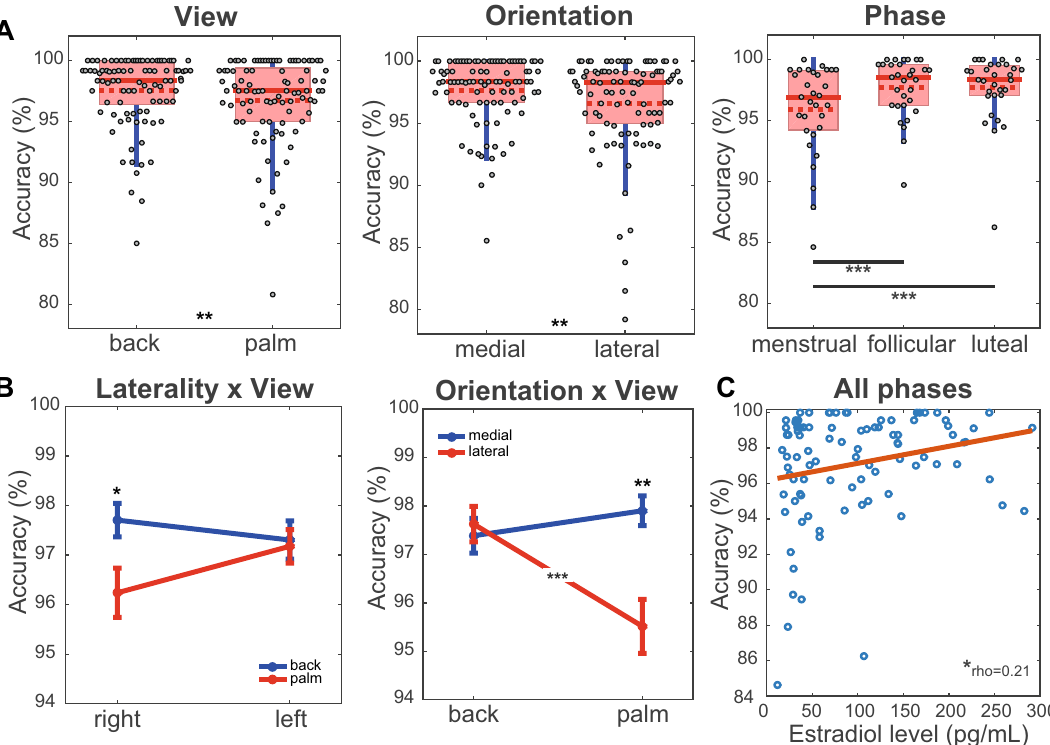
Figure 6. Effects of hand features and menstrual cycle on the accuracy. ( A ) Main effect of hand features on the accuracy. ( B ) Effect of interaction between hand features on the accuracy. ( C ) Correlation between accuracy and estradiol level. The main effects are presented in a boxplot. The filled red line in the boxplot represents the median and the dotted red line represents the mean. The interactions are presented as mean and standard error. P -value: < 0.001 (***), < 0.01 (**), < 0.05 (*); Bonferroni correction for post-hoc